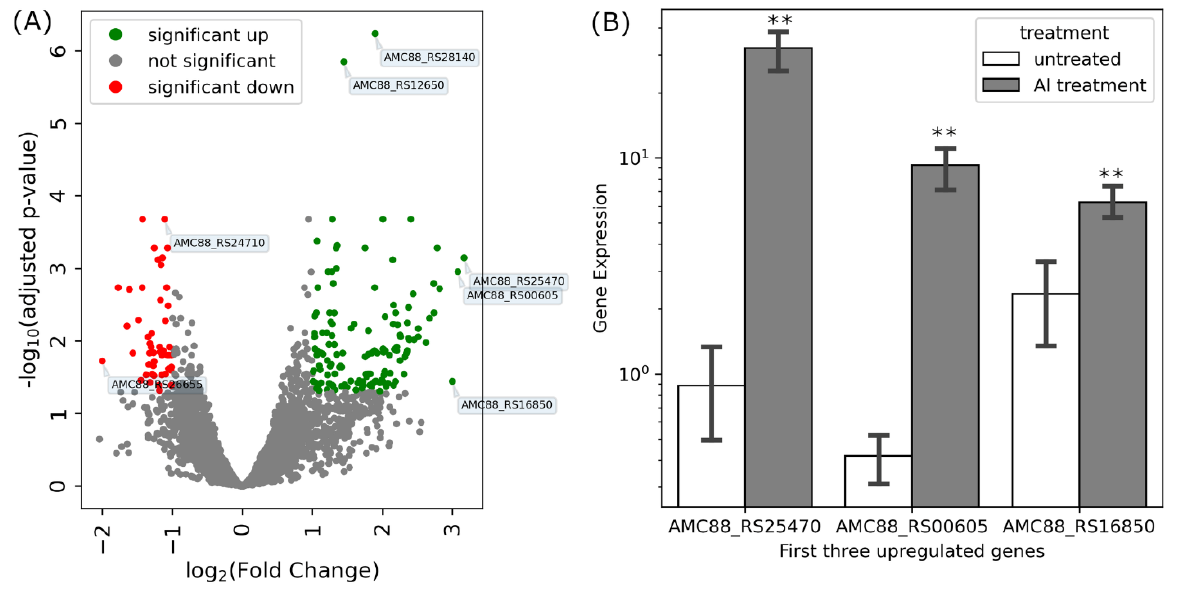
Figure 5. Gene expression analysis of Al-treated B3 cells compared to untreated control cells. A volcano plot ( A ) shows significantly different (colored) or not significantly different (grey) up-and down-regulated genes in Al-treated cells. ( B ) Quantitative real-time PCR of the three upregulated genes, highlighted in panel ( A ). Asterisks in ( B ) represent significant differences in transcript abun- dance between Al treated samples and untreated controls (one-way ANOVA; ** p ≤ 0.001).